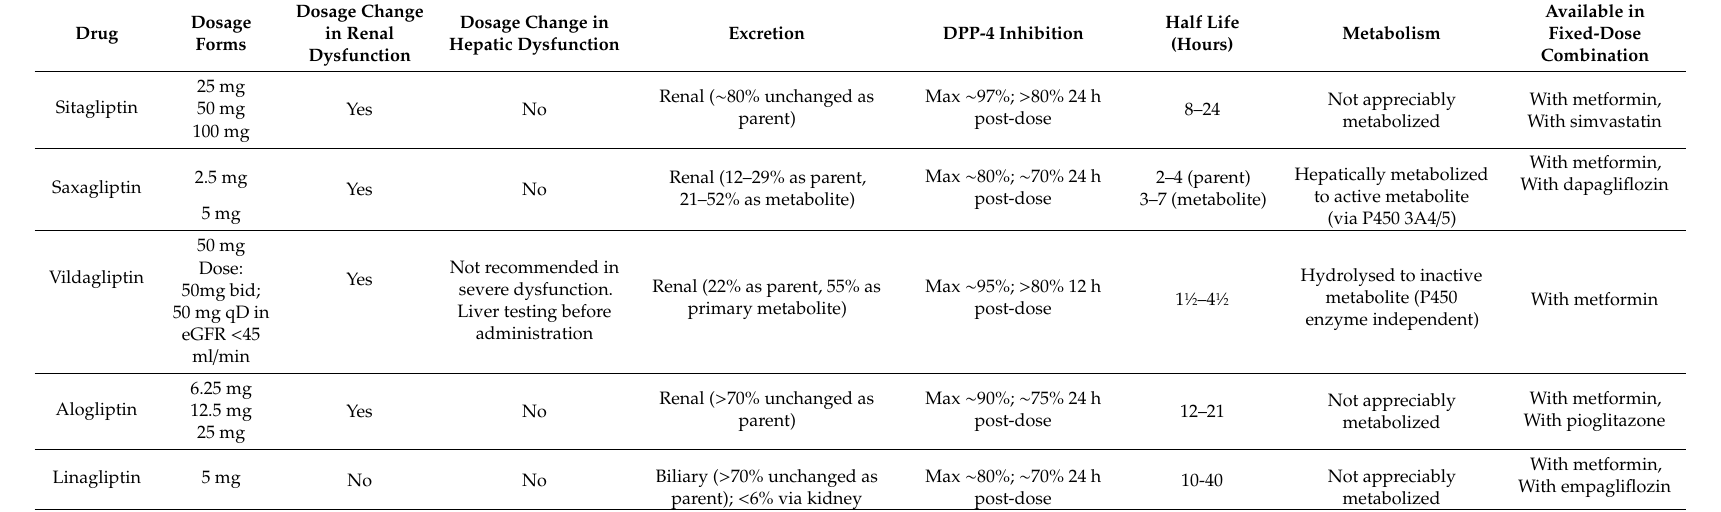
Table 1. Comparison of currently marketed DPP-4